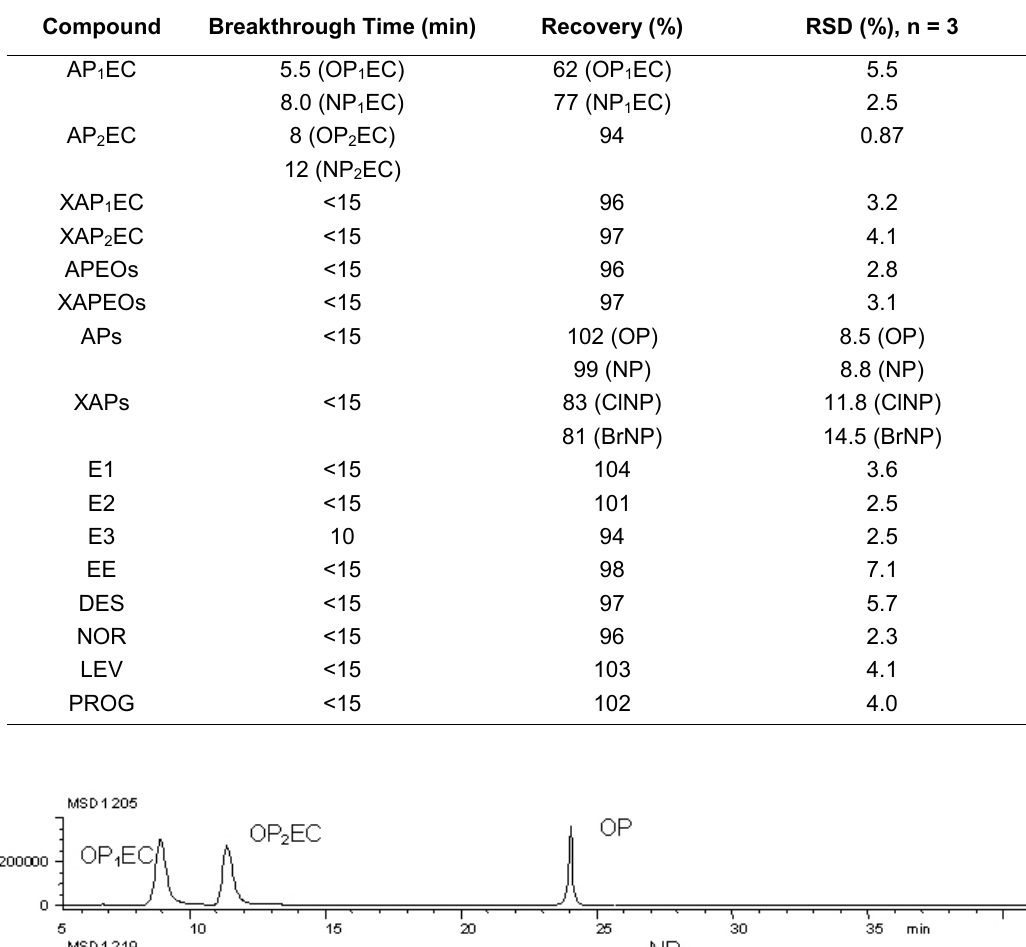
Validation Parameters of RAM–LC–MS Integrated Method Using LiChrosphere ADS-C4